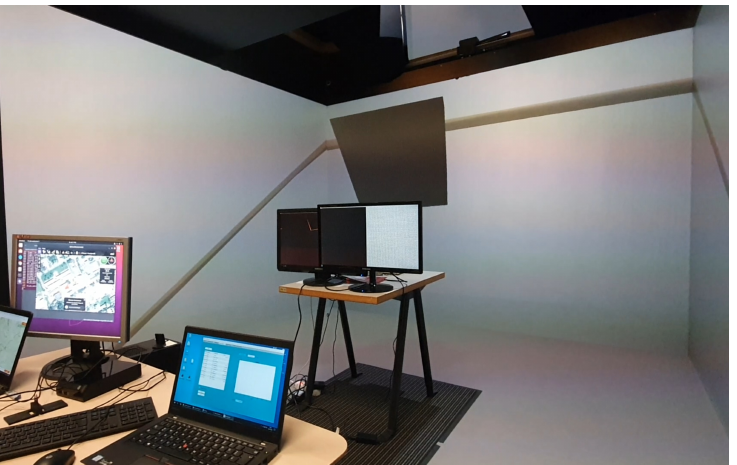
Figure 4. An abstracted environment, e.g., consisting only of the horizon and a box, can be used to test the basic functionality of the collision avoidance